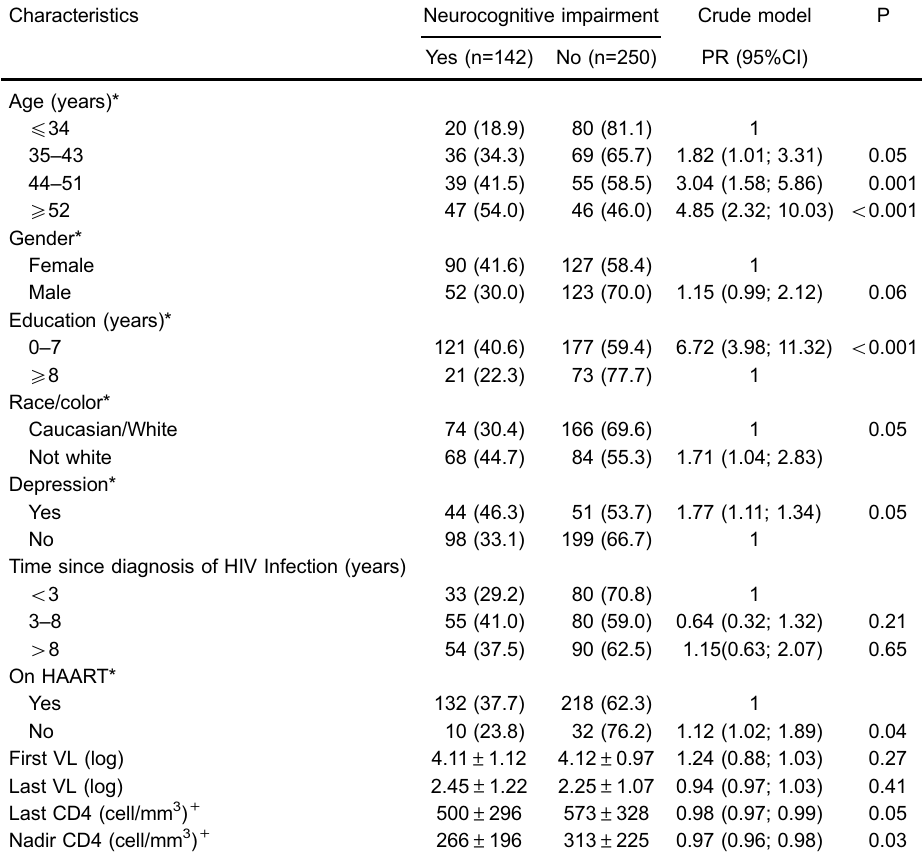
Table 2. Bivariate analysis of patient characteristics according to cognitive performance.